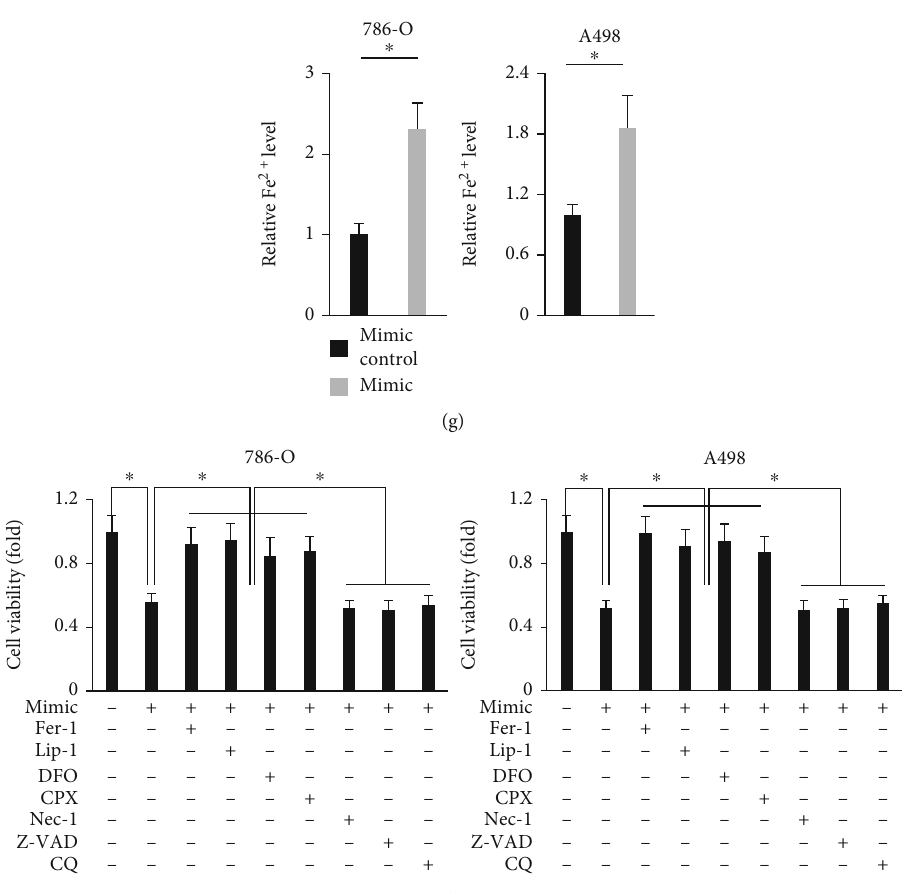
Figure 2: Overexpression of miR-4735-3p induces ferroptosis of human ccRCC cell lines. (a) Relative expression of miR-4735-3p in human ccRCC cell lines treated with the miR-4735-3p mimic or mimic control. (b) Cell viability was examined by the MTT method. (c) Relative LDH level in the medium from the miR-4735-3p mimic or mimic control-treated ccRCC cells. (d and e) Relative ROS and MDA levels. (f and g) Relative intracellular iron and Fe 2+ levels. (h) Cell viability in the miR-4735-3p mimic-treated ccRCC cells in the presence of various cell death inhibitors. N = 6 per group. All data were expressed as the mean ± SD ; ∗ P < 0 : 05 was considered signi fi